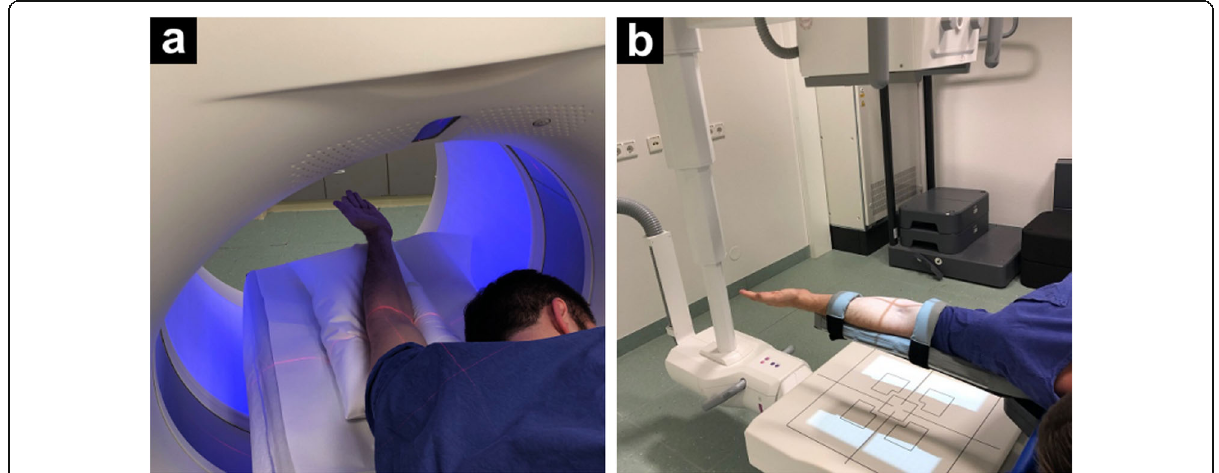
besides the patient table